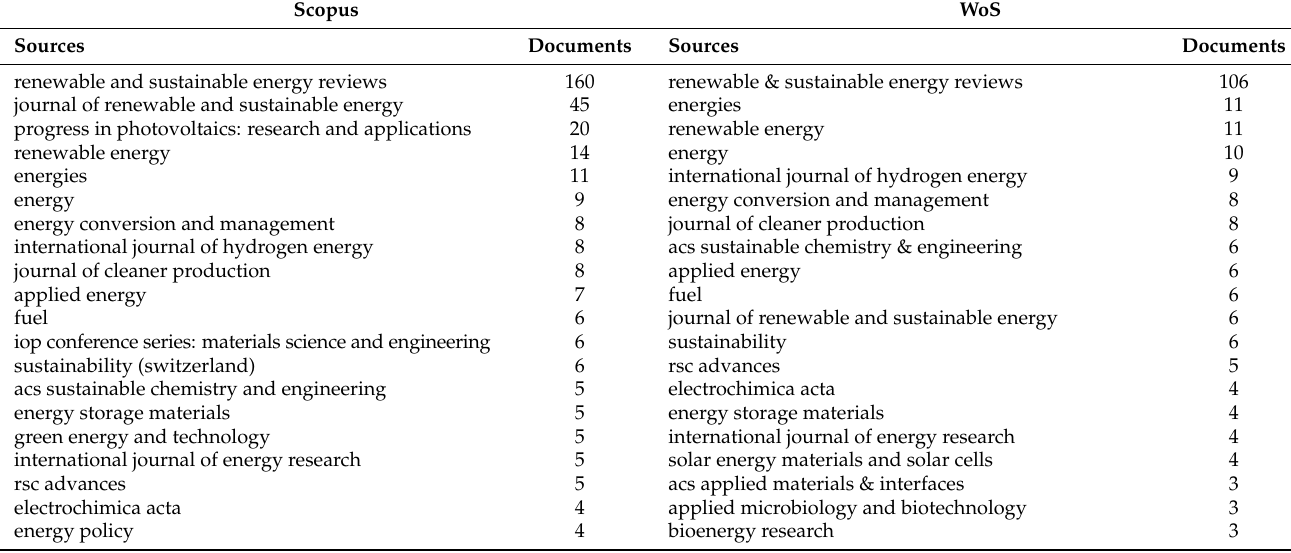
Table 4. Top-20 networked sources from Scopus and WoS databases for bibliographic coupling links.